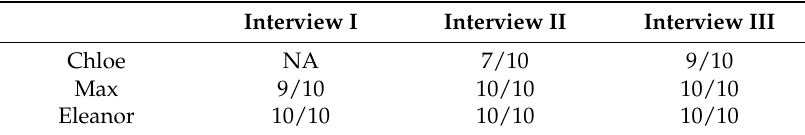
Table 5. Accuracy of pronouns in GJT.